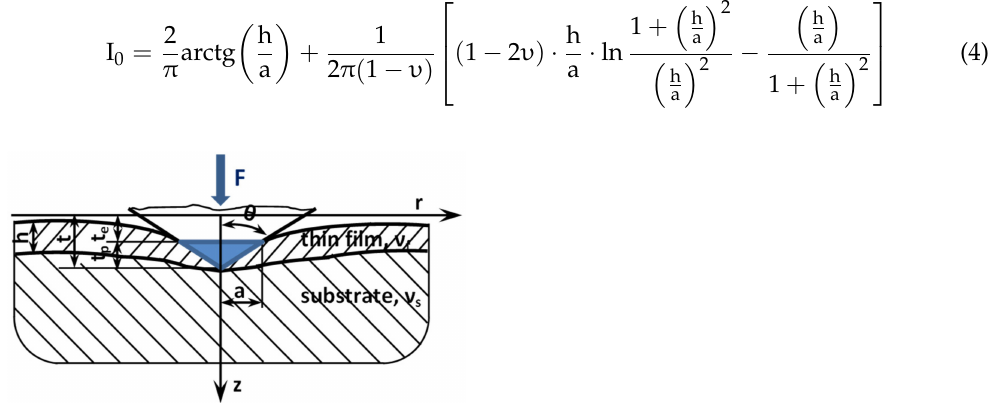
Figure 19. A Berkovich indenter penetrating a thin film/substrate